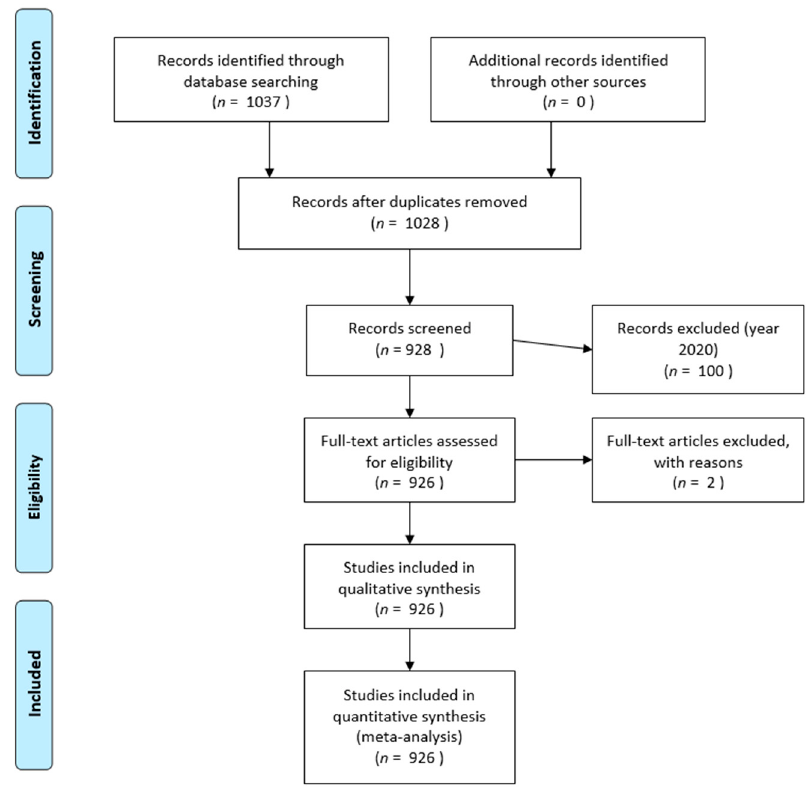
Figure 1. Flowchart according to the PRISMA declaration.